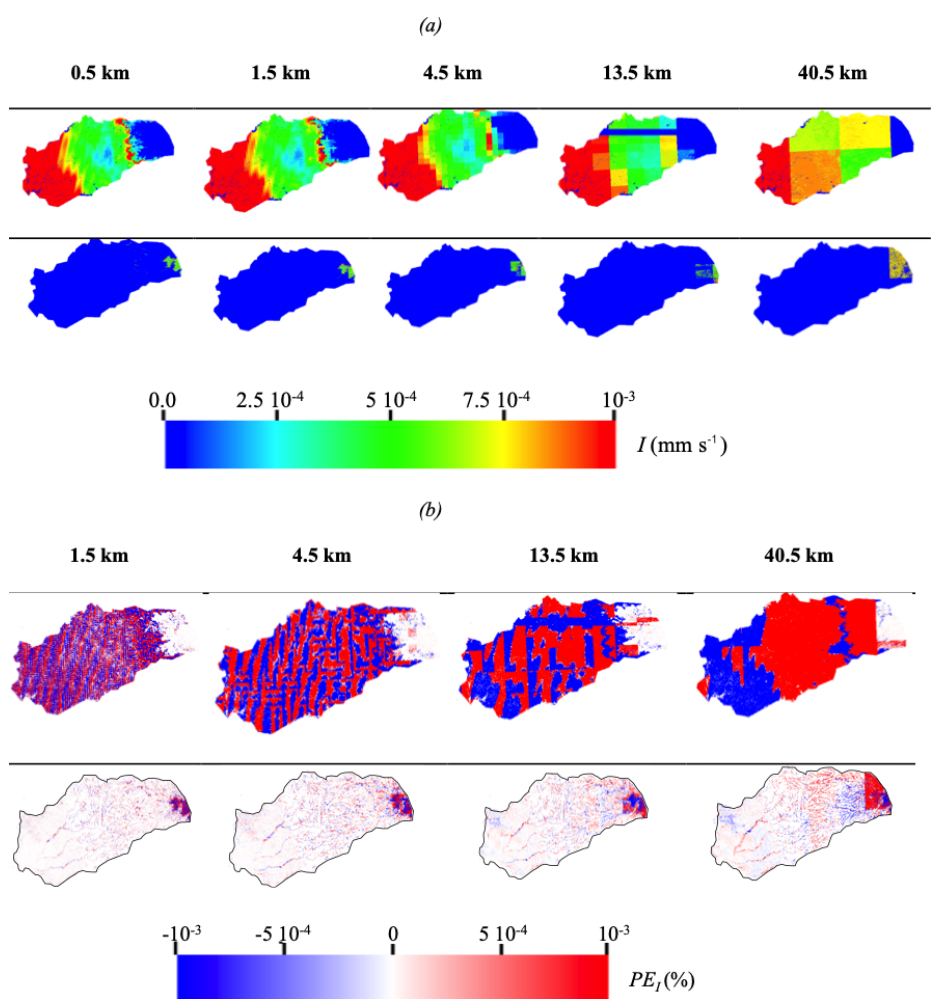
Figure 7. Spatial distributions of (a) infiltration I obtained with the five spatial resolutions of meteorological and (b) the percent error of infiltration (PE I ) with respect to the highest spatial resolution of meteorological forcing (0.5km). Results are shown in winter (WY day 83) and summer (WY day